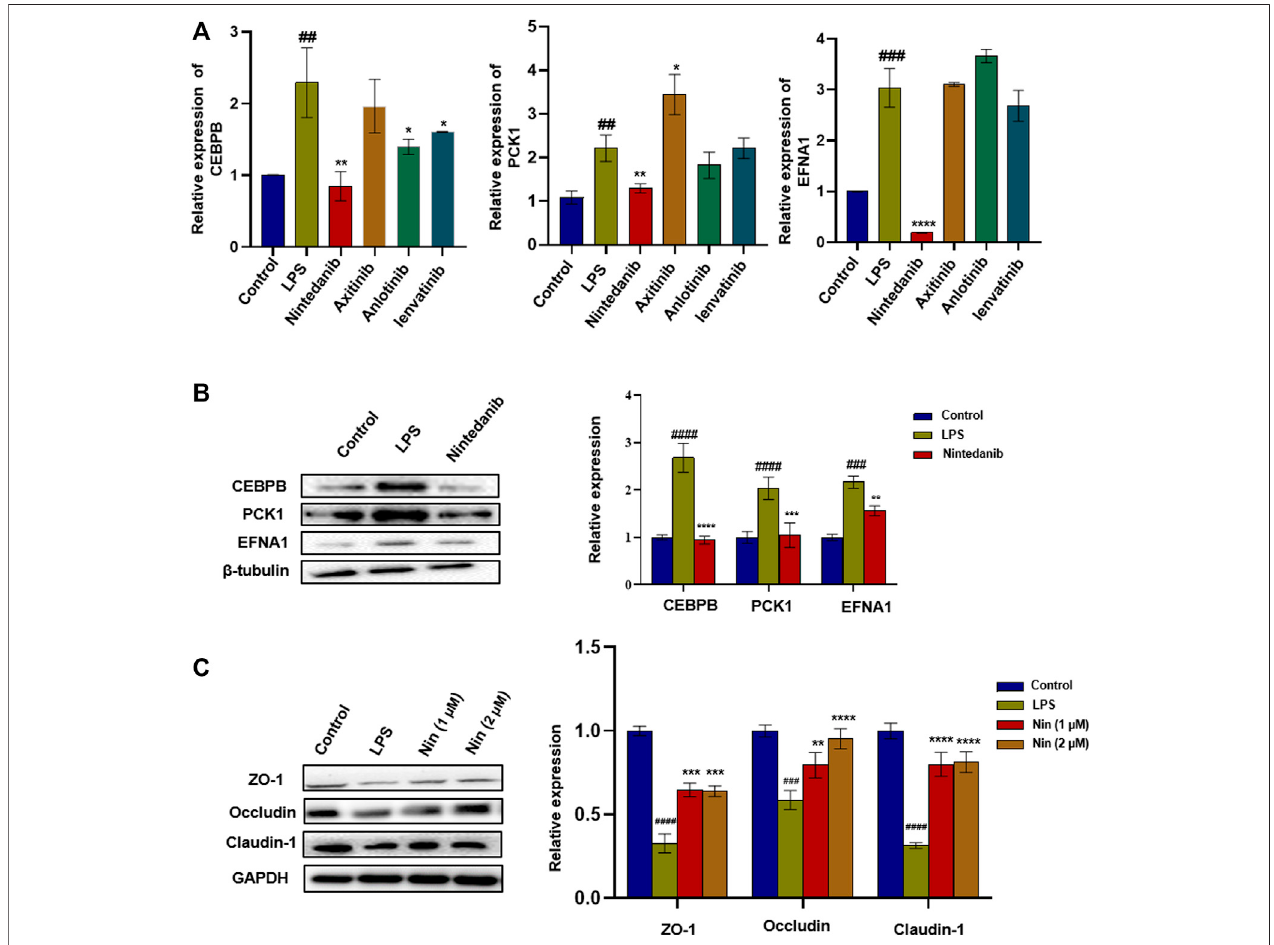
FIGURE 3 | Screening of tyrosine kinase inhibitors and the effect of nintedanib on barrier protein in Caco-2 cells. (A) Screening of tyrosine kinase inhibitors in LPS- induced Caco-2 cells. (B) Nintedanib signi fi cantly inhibited the protein expression levels of CEBPB, PCK1, and EFNA1. (C) Nintedanib improves the injury of intestinal epithelialbarrierprotein invitro .Dataarepresentedasthemean±SD( n =3). # p < 0.05, ## p < 0.01, ### p < 0.001and #### p < 0.0001signi fi cantlydifferentfromthecontrol group; *p < 0.05, **p < 0.01, ***p < 0.001, and ****p < 0.0001, signi fi cantly different from LPS